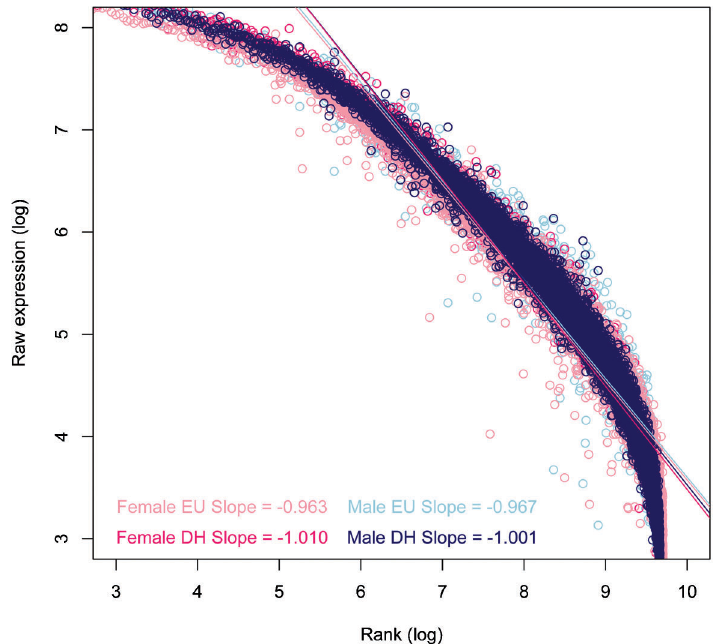
Figure 1. Raw microarray data from the supraop- tic nucleus, considered Present in either the euhydrated (EU) or dehydrated (DH) state, were used. Male and female data were handled separately. The median expression value calcu- lated for all samples set the experiment log rank against which the log expression per condition was then plotted. Slope, intercept and linear regression (least squares) were then calculated. The slope is closer to Zipf’s exponent of ––1 following DH compared to the EU